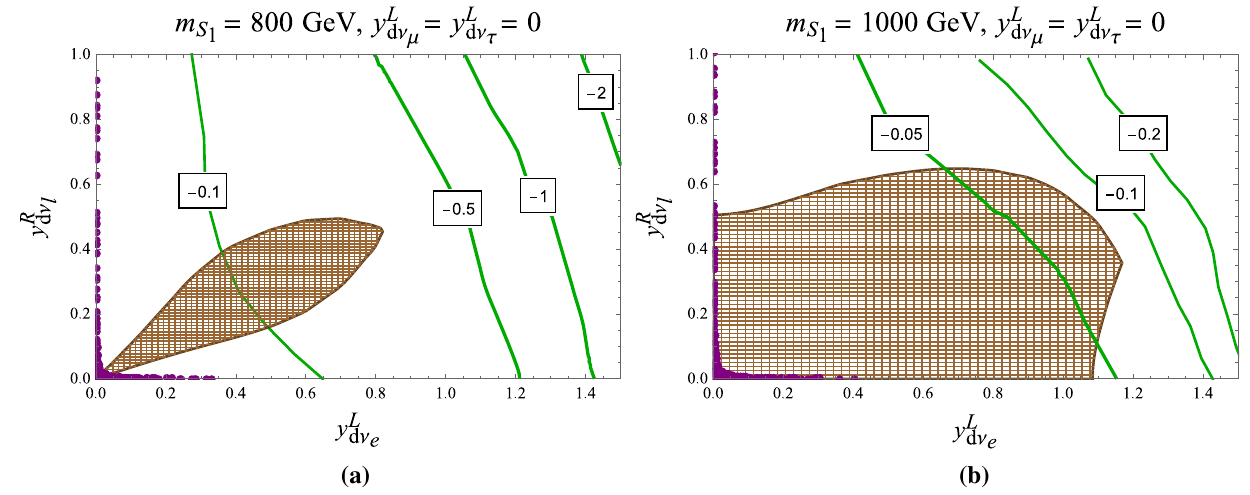
Fig. 9 The allowed parameter space at 95% C.L. from the 13TeV LHC direct LQ searches is shown in brown in the y L = y L = 0 for m = 800GeV (left panel) and m y L S 1 d ν μ d ν τ